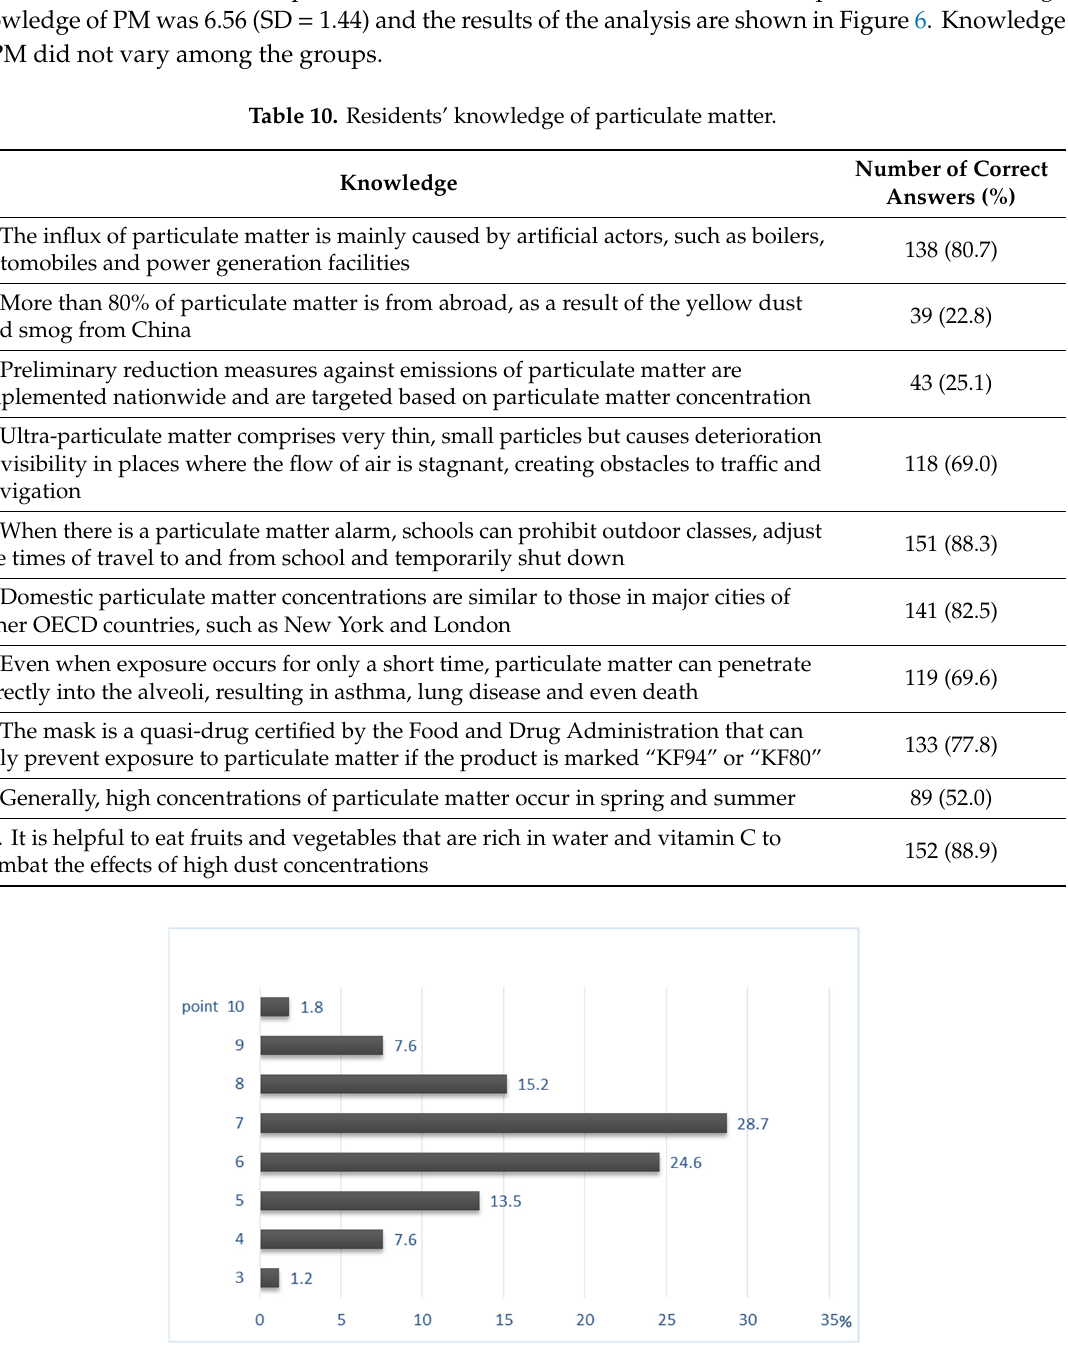
Figure 6. Residents’ total knowledge of particulate matter.